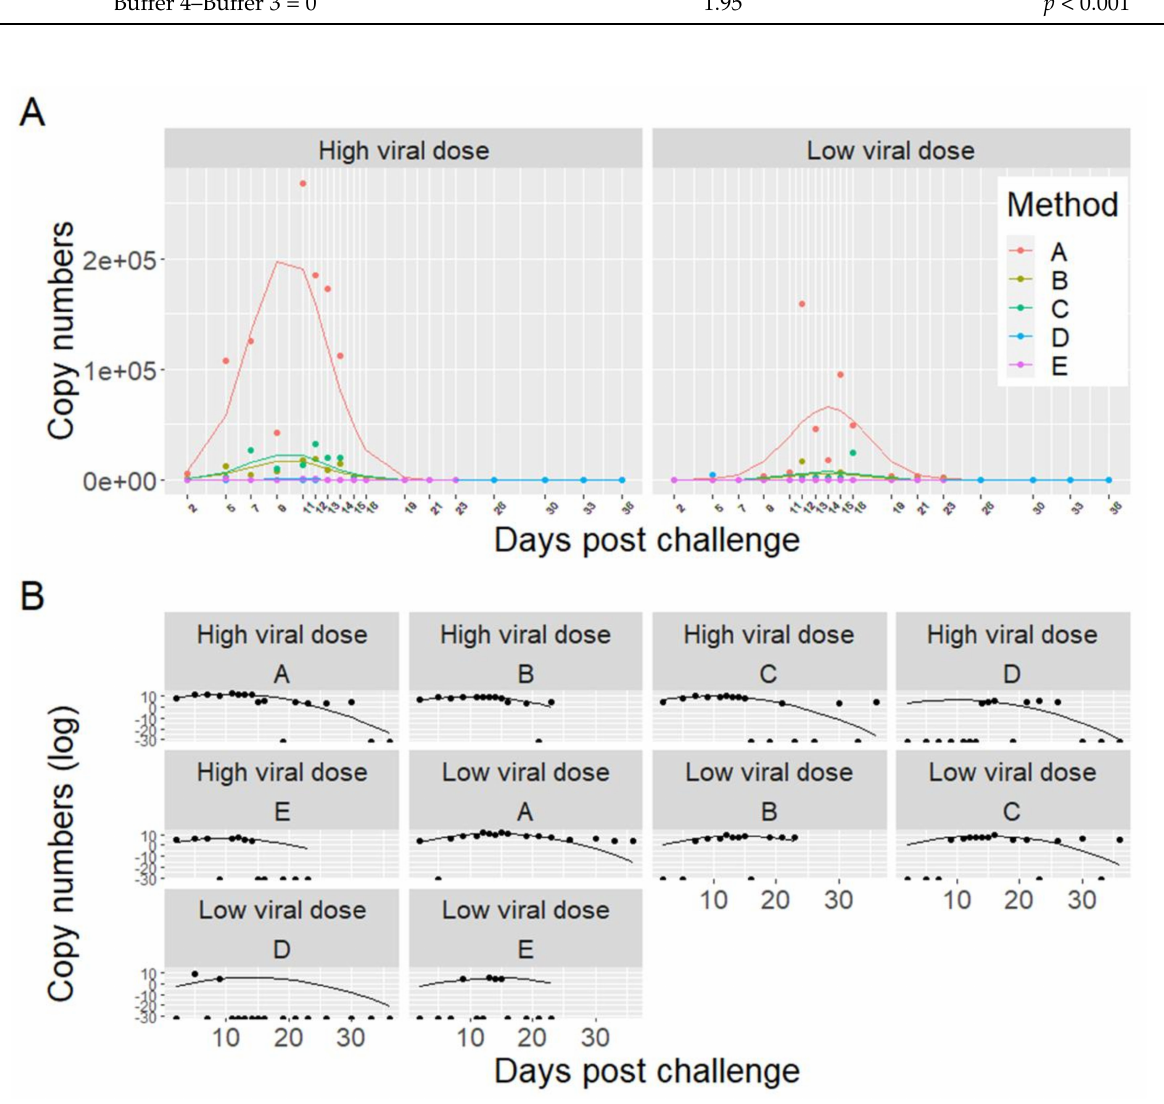
Figure 5. Comparison of five different concentration methods ( A – E ) for detection of infectious salmon anemia virus RNA from 1 L seawater collected from high viral dose (HDg) and low viral dose (LDg) ISAV exposed tanks. ISAV RNA in seawater samples were measured using a RT-ddPCR assay which targeted segment 8 of the ISAV genome. The dots represent the observed data, while the lines represent the model predictions. Panel A illustrates the untransformed data. Panel B illustrates each method and dose separately with copy numbers transformed with the natural logarithm to better illustrate the data points and model fit. Note that taking the logarithm of zero returns negative infinity. This is illustrated with half points at the bottom of the graphs in ( B